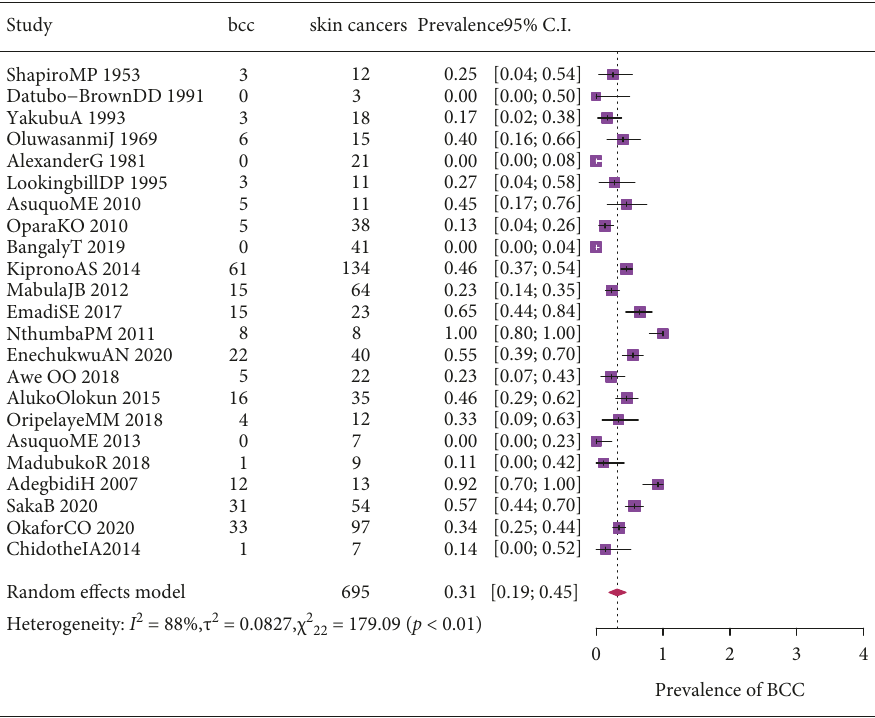
Figure 3: Forest plot showing the pooled prevalence of basal cell carcinoma.